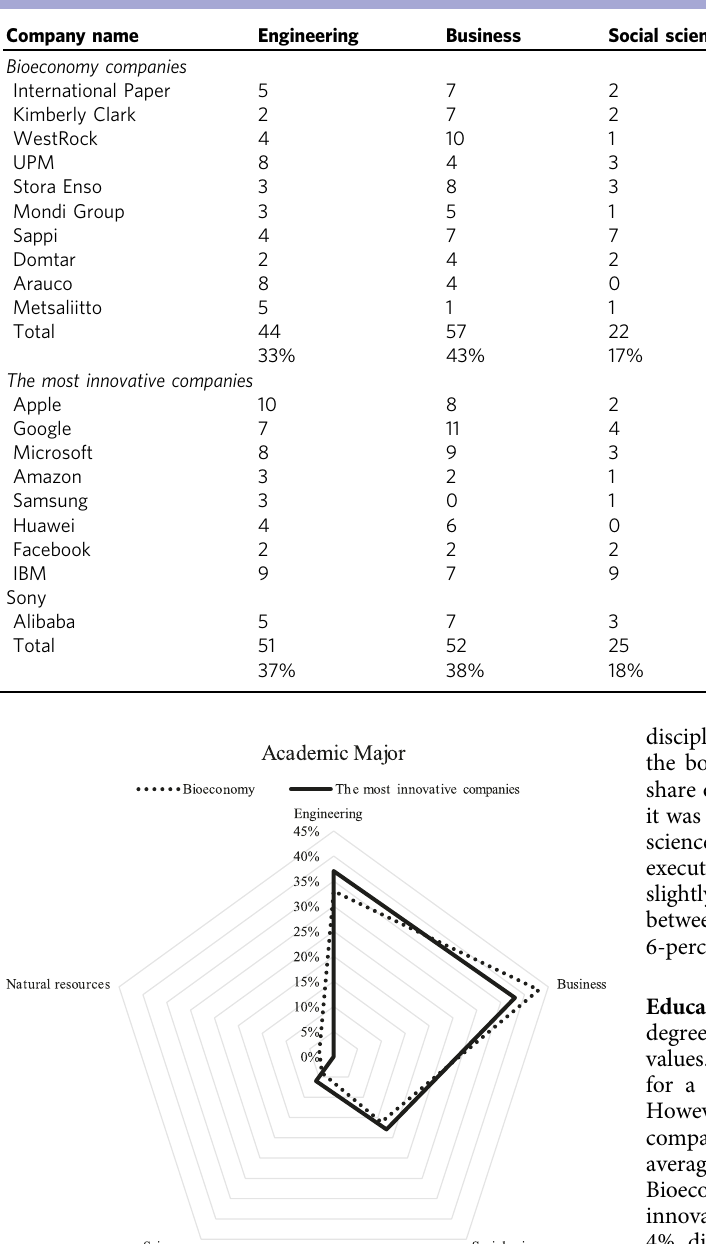
Table 1 Educational disciplines for executive team members in both company